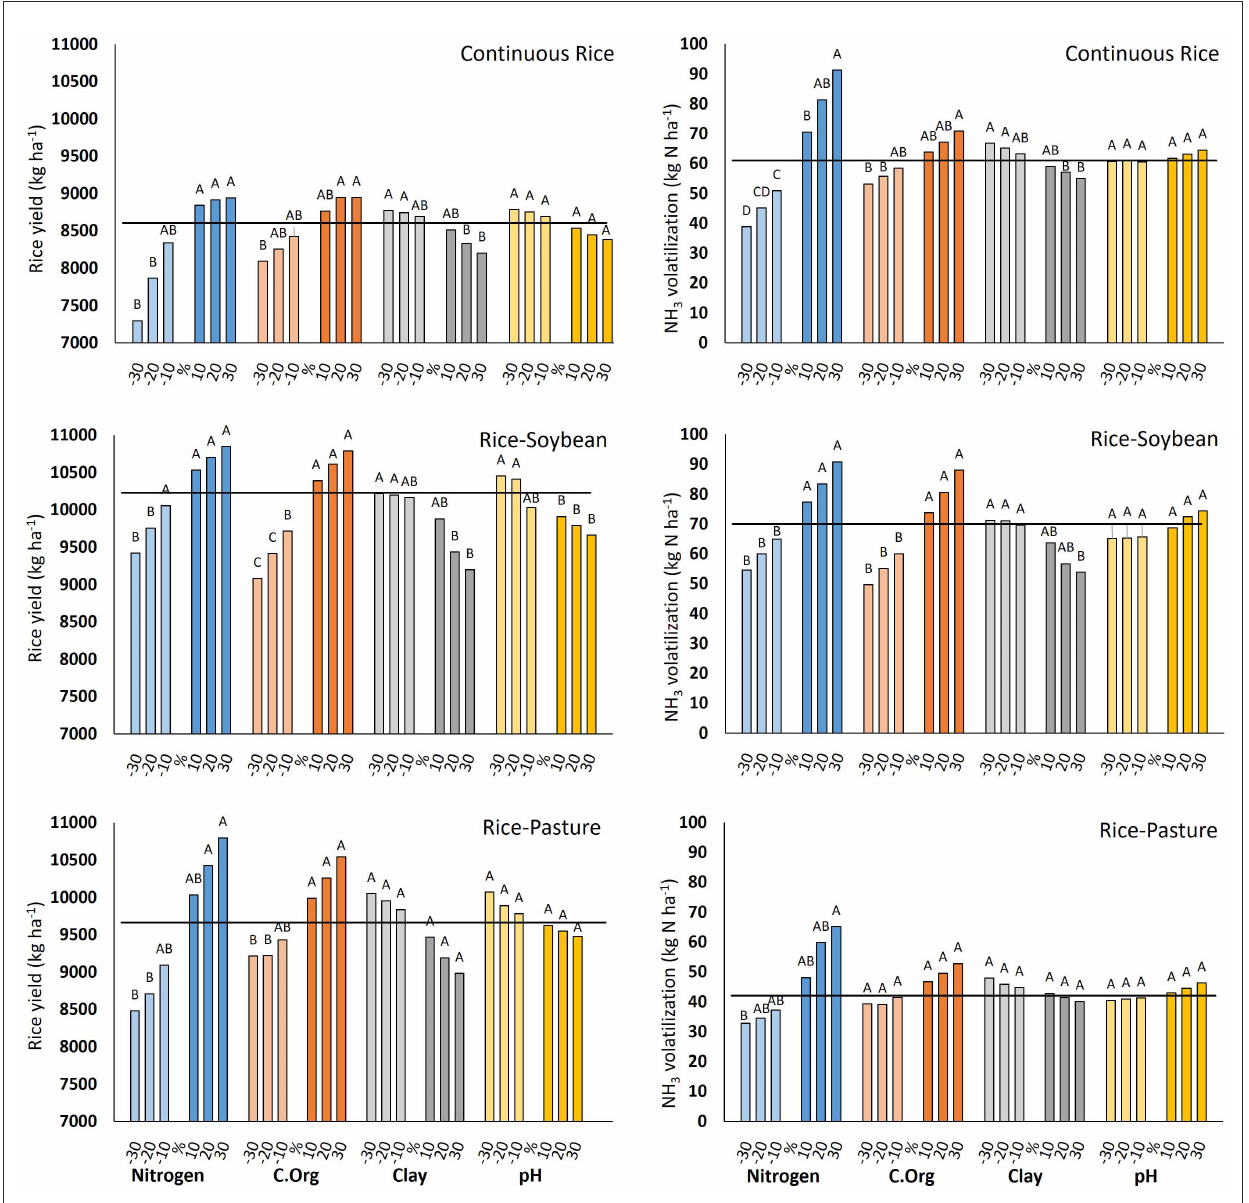
FIGURE5 Sensitivity of modeled NH 3 volatilization and rice grain yield to variations in the N fertilization rate and soil organic C content, clay content, and pH. The parameter values were varied individually by the indicated values. The horizontal lines are the results with the standard parameter values. Letters next to bars indicate differences (Fisher 5%) associated with percentage variation of each indicated soil parameter.